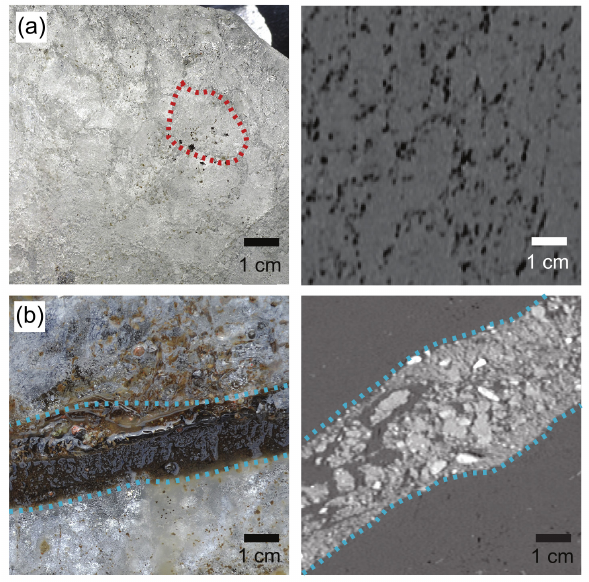
Figure 3. Photographs (left) and CT scans (right) of the massive ice body. (a) Pure-ice facies. The dotted red line highlights one single crystal; (b) ice-poor sediment (sands and gravels) with suspended and crustal cryostructures forming a band in the massive ice.